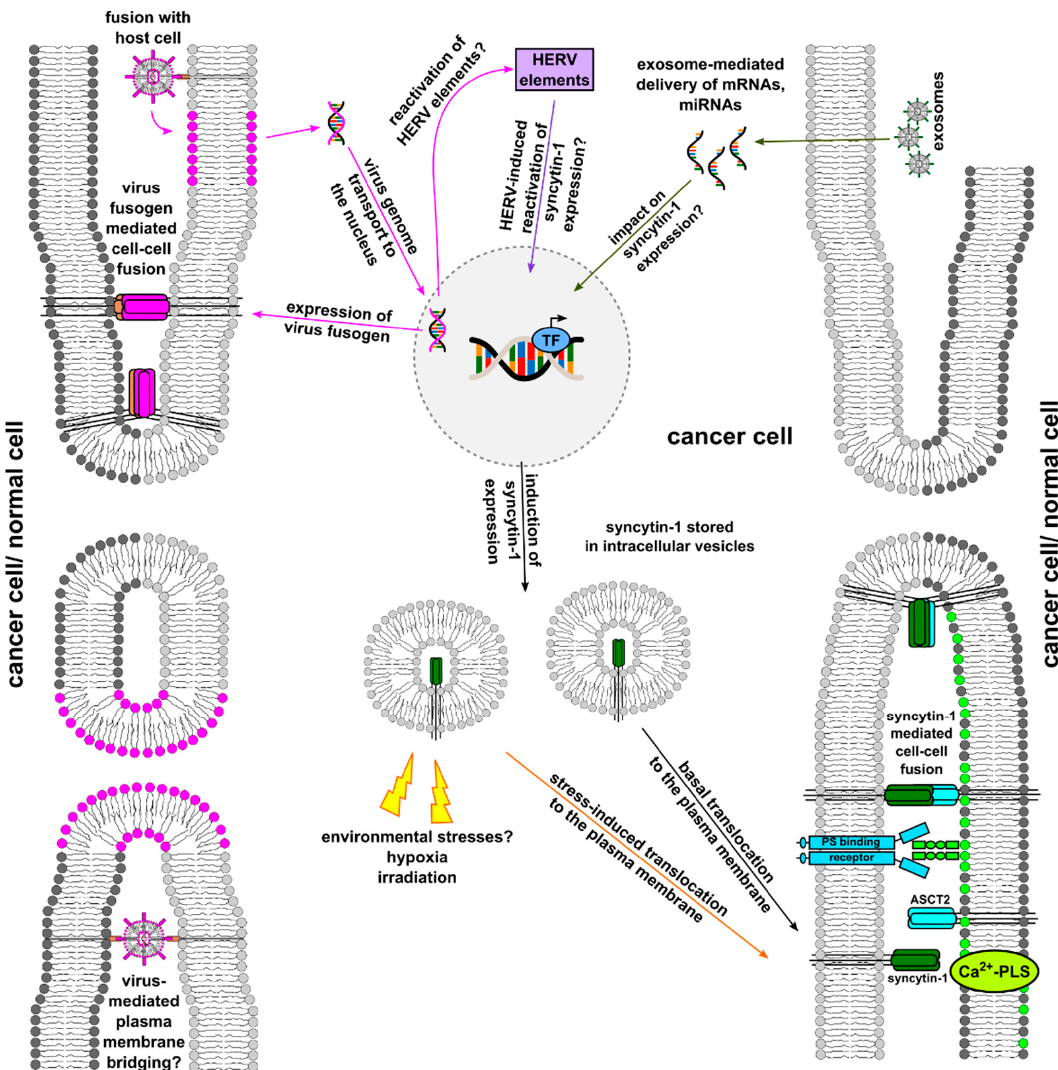
Figure 3. Cancer cell–cell fusion triggered by environmental stress, viruses, and exosomes. In accordance to Figure 2, fusogens and their cognate receptors, as well as PS and PS-binding proteins, are indispensable for cancer cell–cell fusion. Induction of fusogen (syncytin-1) expression could be putatively triggered by mRNAs and miRNAs delivered by exosomes. The role of viruses in cancer cell–cell fusion is less clear. Although still unclear, cell-surface-associated viruses may directly act as bridging elements for two individual cells. Moreover, virus infection and subsequent expression of viral fusogens represent another mechanism that might cause membrane merger of two (or more) individual cells. A potential re-activation of syncytin-1 expression in cancer cells by HERV elements and a fusion-related role of other virus-derived elements upon infection remain less clear. Extracellular stress, such as hypoxia and/or irradiation, might trigger translocation of fusogens (syncytin-1) from intracellular vesicles towards the plasma membrane.